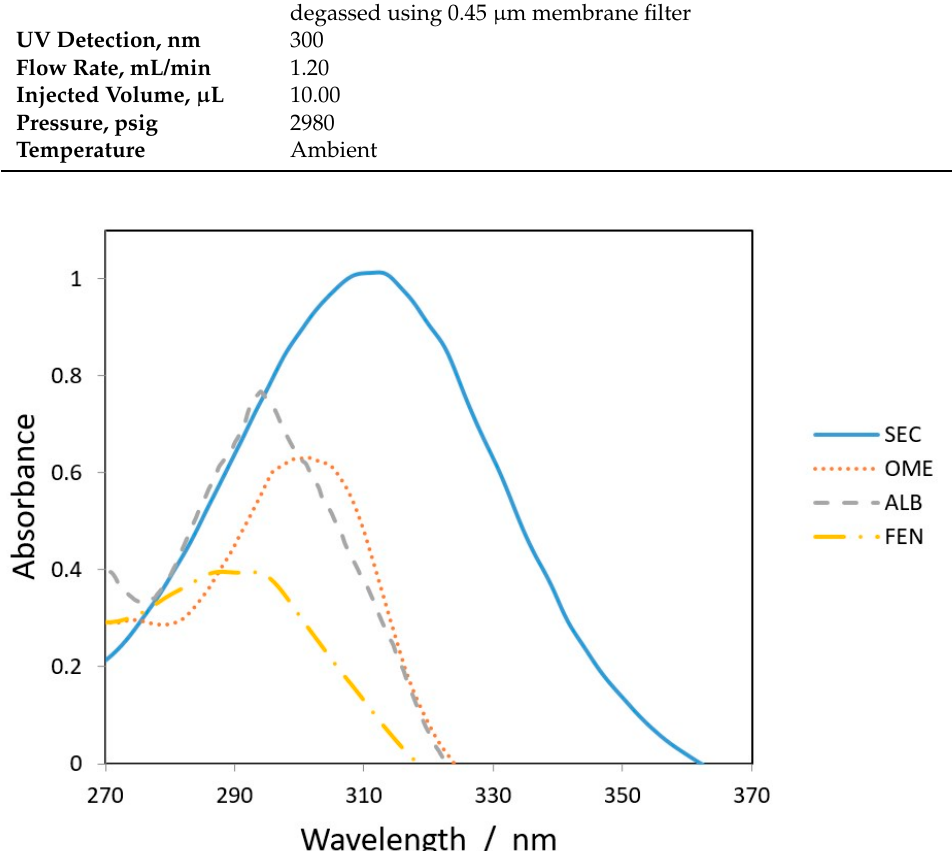
Figure 2. Overlain spectra of 25 µg/mL (SEC___), (OME.....), (ALB_ _ _ _) and (FEN _._._.) at 312, 301, 294, and 288 nm, respectively.